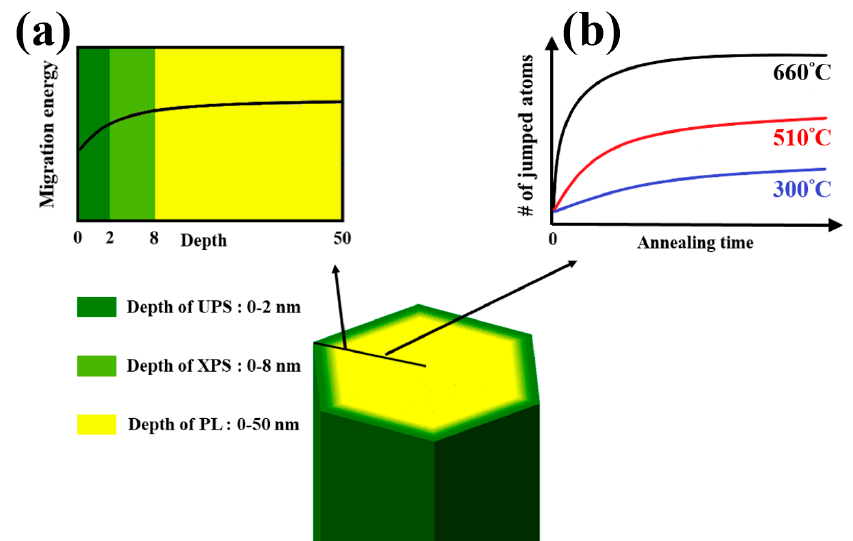
Figure 7. The distribution of the migration energy barrier in ZNRs ( a ) The trend of the surface migration energy barriers in the depth of 50 nm from the ZNR surface. ( b ) The correlation of annealing temperature and time to reach the completed ZNRs.